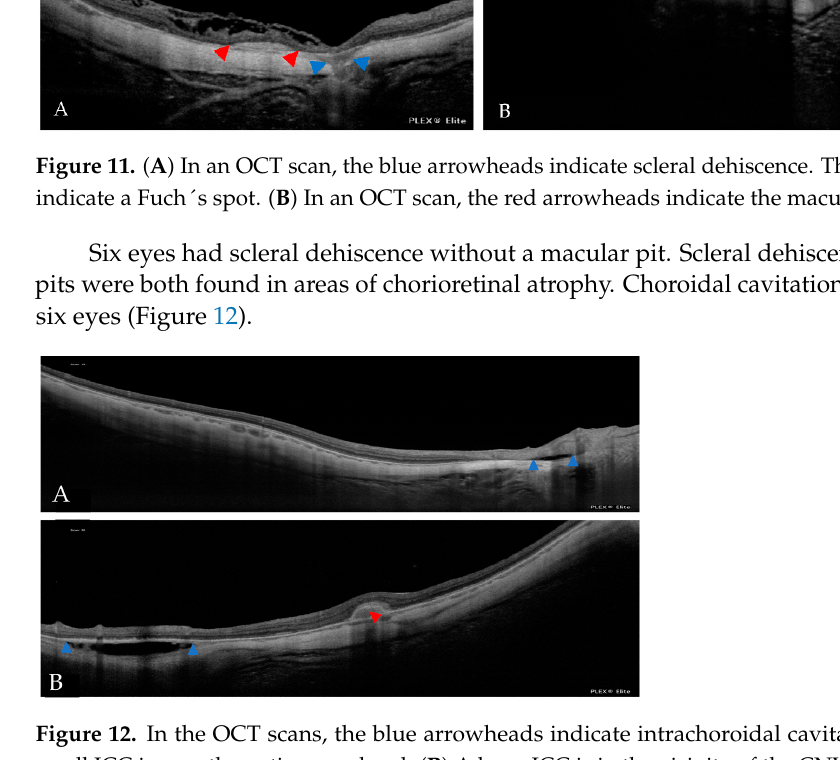
Figure 12. In the OCT scans, the blue arrowheads indicate intrachoroidal cavitation (ICC). ( A ) A small ICC is near the optic nerve head. ( B ) A large ICC is in the vicinity of the CNV (red arrowhead). Seventy-seven eyes (43%) had vascular folds in the HD51 scan (Figure 13). PSV were detected in 159 eyes (88.8%) and 16 of them were related to a Fuch´s spot and 4 eyes with active CNV. Seven eyes had PSV with lacquer cracks. Figure 13. In an OCT scan, the blue arrowheads indicate vascular folds. Concerning the retinal, choroidal, and scleral foveal thicknesses, six eyes were ex- cluded due to their inability to detect the fovea, mainly because of macular atrophy (Fig- ure 14).